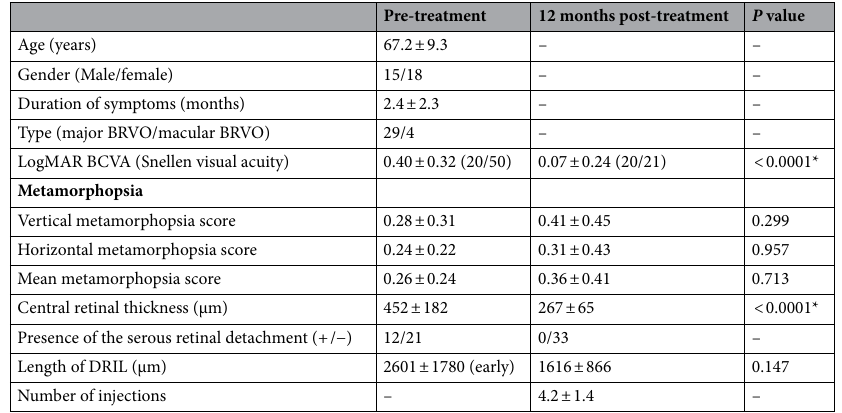
Table 1. Clinical characteristics and time course of changes in visual functions and retinal microstructure following intravitreal ranibizumab injection in patients with branch retinal vein occlusion. BRVO branch retinal vein occlusion, LogMAR logarithm of minimal angle of resolution, BCVA best-corrected visual acuity, DRIL disorganization of the retinal inner layers. Values are presented as the mean ± standard deviation. *Significant correlations found between the parameters (One-way analysis of variance and Bonferroni